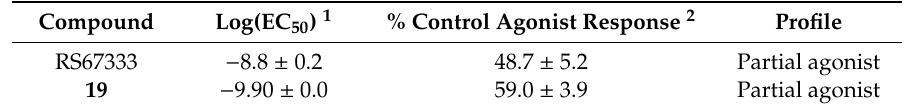
Table 2. ( h )5-HT 4(a) pharmacological profile of RS67333 and compound 19 . 5-HT was used as a control 5-HT 4 R agonist.